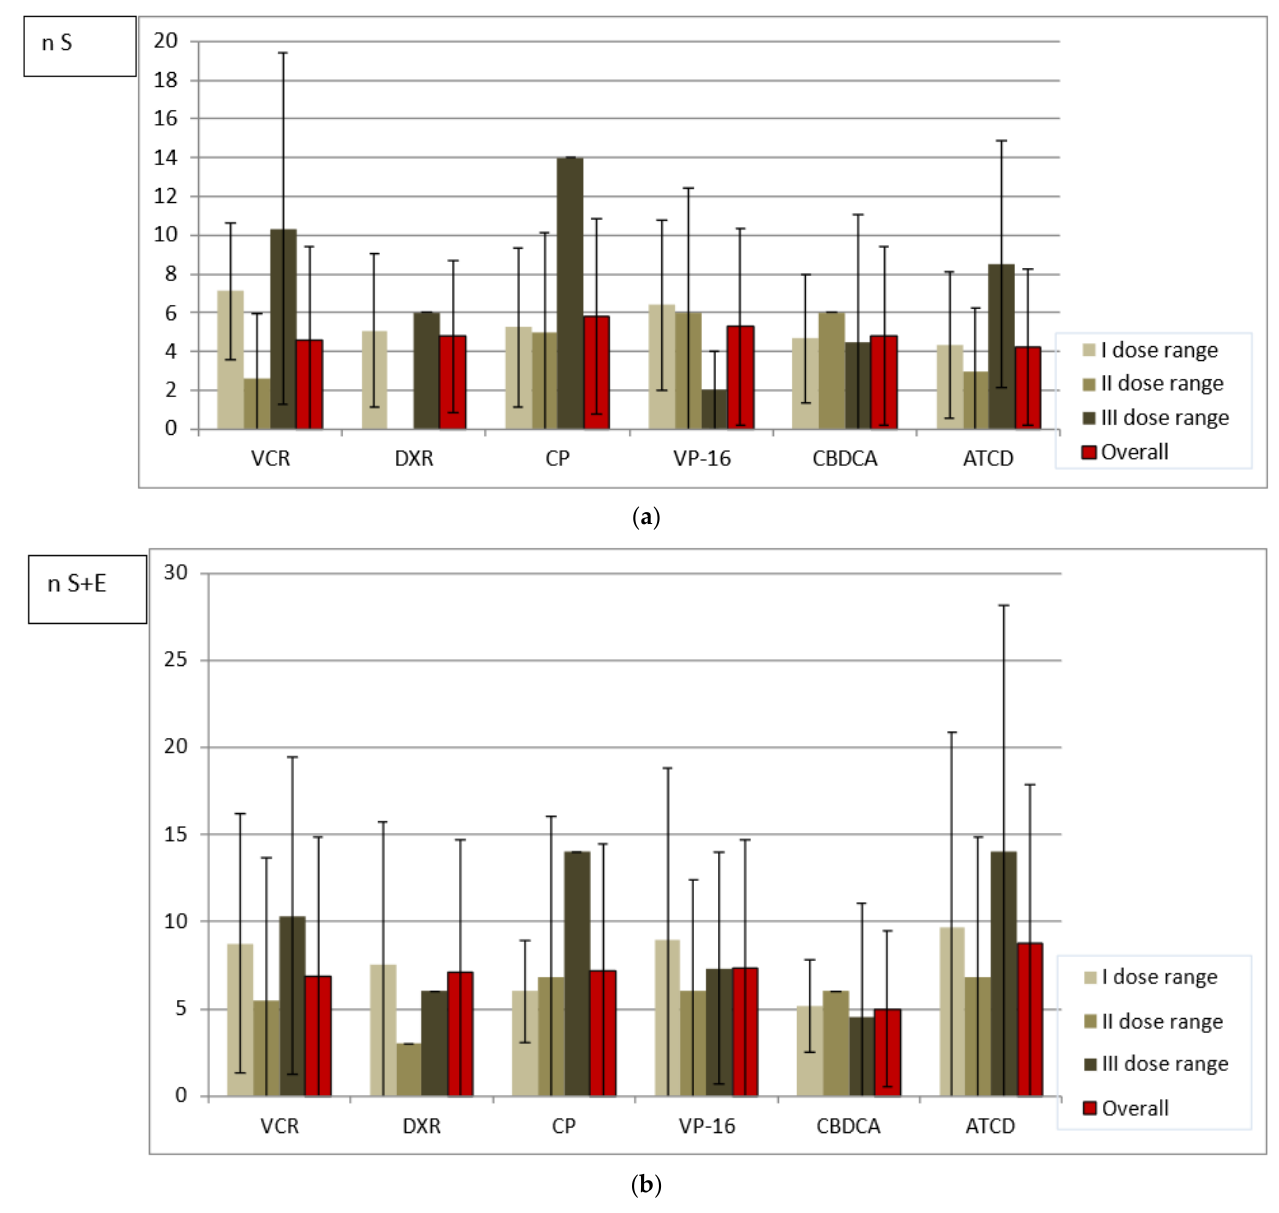
Figure 1. ( a ) Mean number of size abnormalities (n S) in relation to three single dose ranges of analyzed drugs. ( b ) Mean number of all abnormalities (n S + E) in relation to three single dose ranges of analyzed drugs.